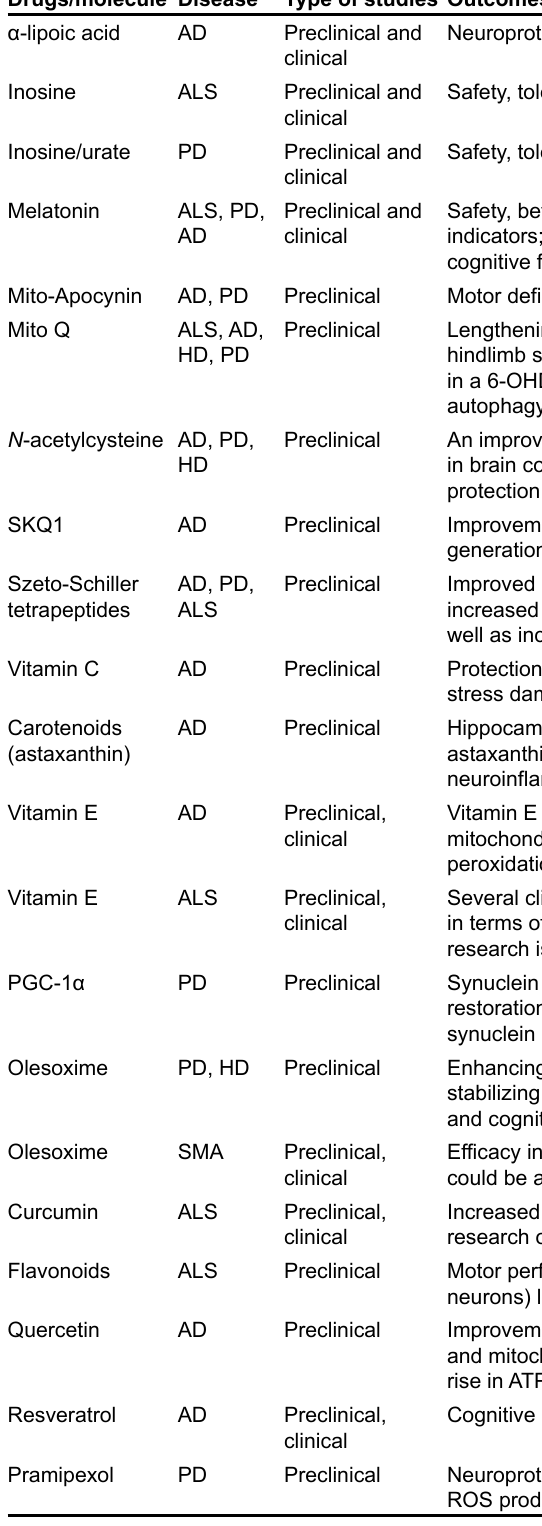
Table 4. List molecules that regulate several mitochondrial functions impaired in neurodegenerative disorder examined under preclinical as well as in clinical trials Drugs/molecule